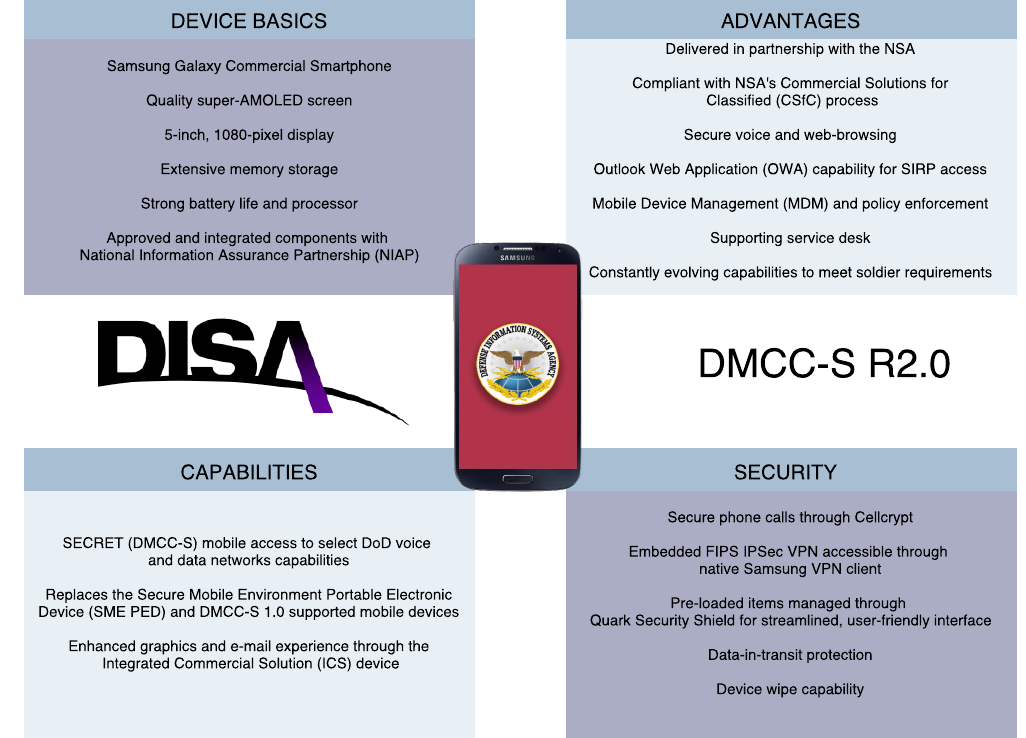
Figure 8. Main characteristics of DMCC-S